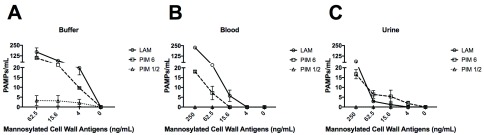
FcMBL ELLecSA screening of
Mycobacterium tuberculosis strain H37Rv glycolipids PIM
1,2, PIM
6, and LAM.Glycolipids spiked into (
A) buffer (TBST 5mM CaCl
2), (
B) whole human blood, and (
C) urine. FcMBL detected LAM and PIM
6 at 4 ng/ml in buffer, but not PIM
1,2. Sensitivity of LAM and PIM
6 is reduced in whole human blood and urine.